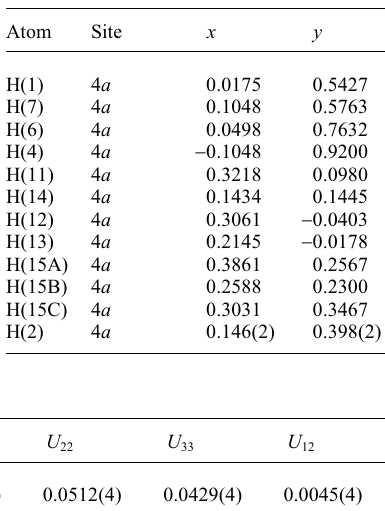
Table 2. Atomic coordinates and displacement parameters (in Å 2 ) .